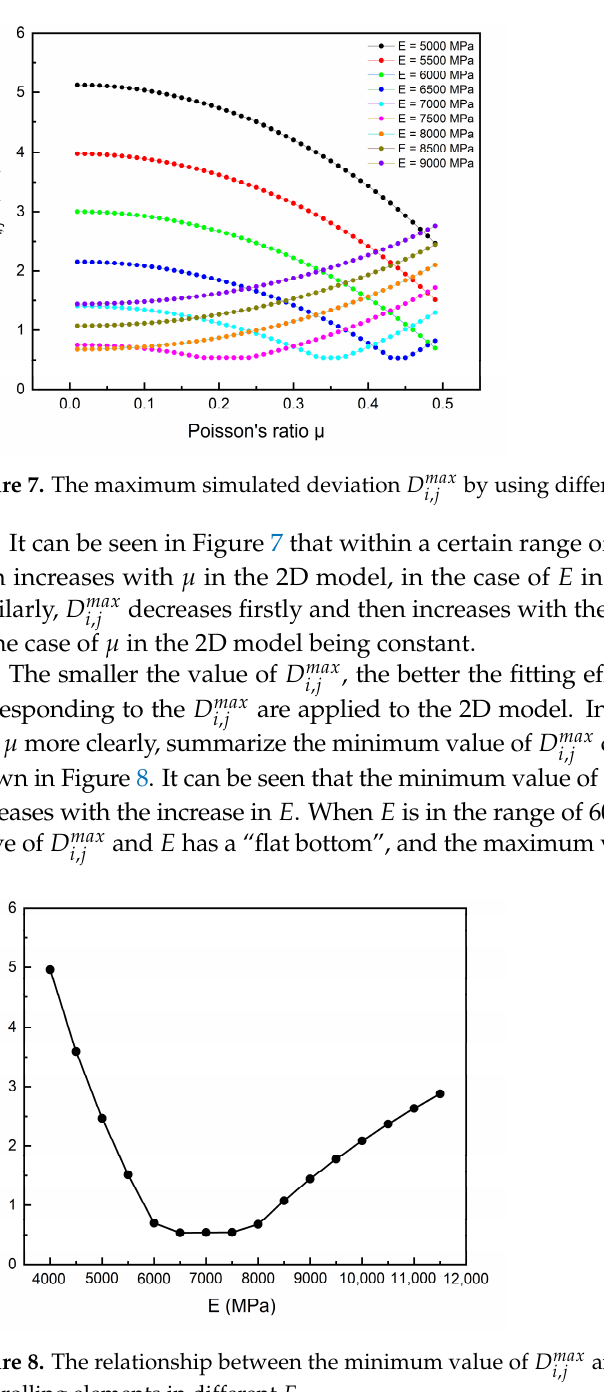
ulus 𝐸 of rolling elements in different 𝐸